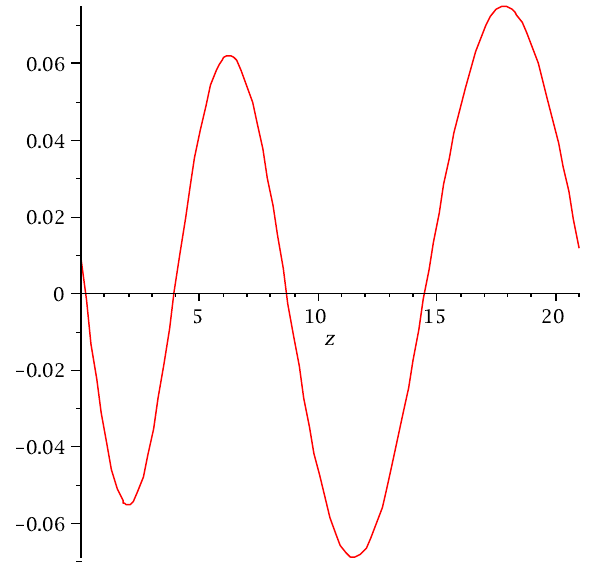
Fig. 3. A plot of of one of the solutions to (99) with N = 1, δ = 0 . 2, α 2 = 0 . 0001 and ω = 0 .